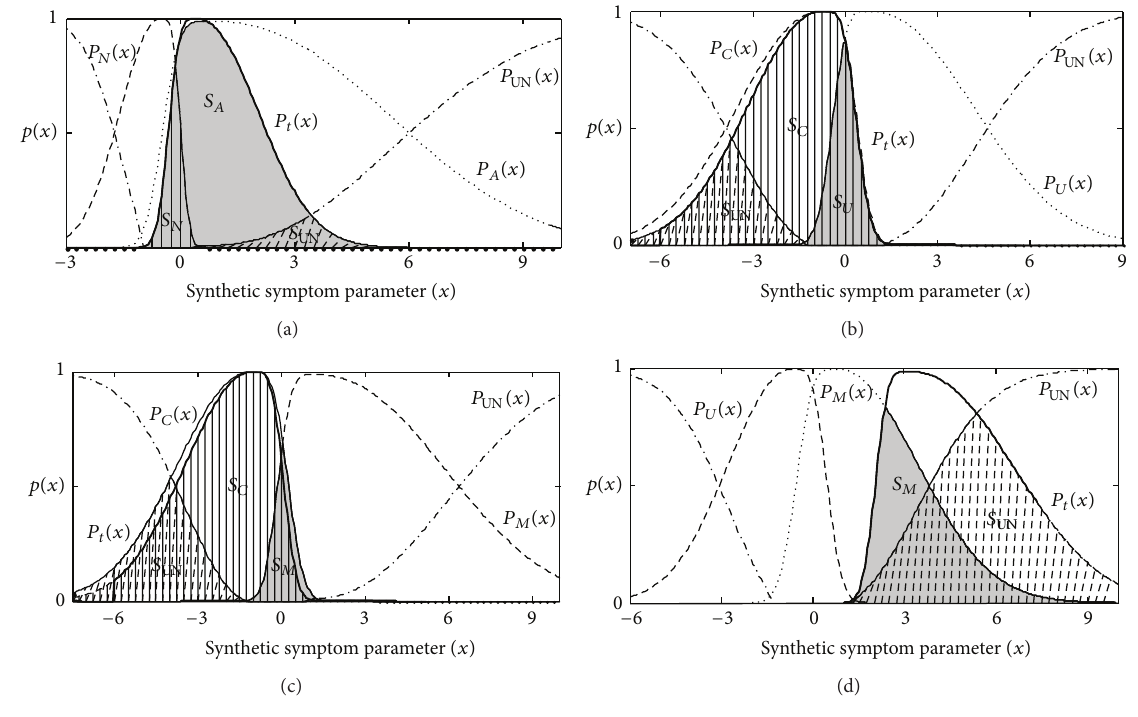
Figure 13: The second diagnostic example using the sequential diagnosis proposed.